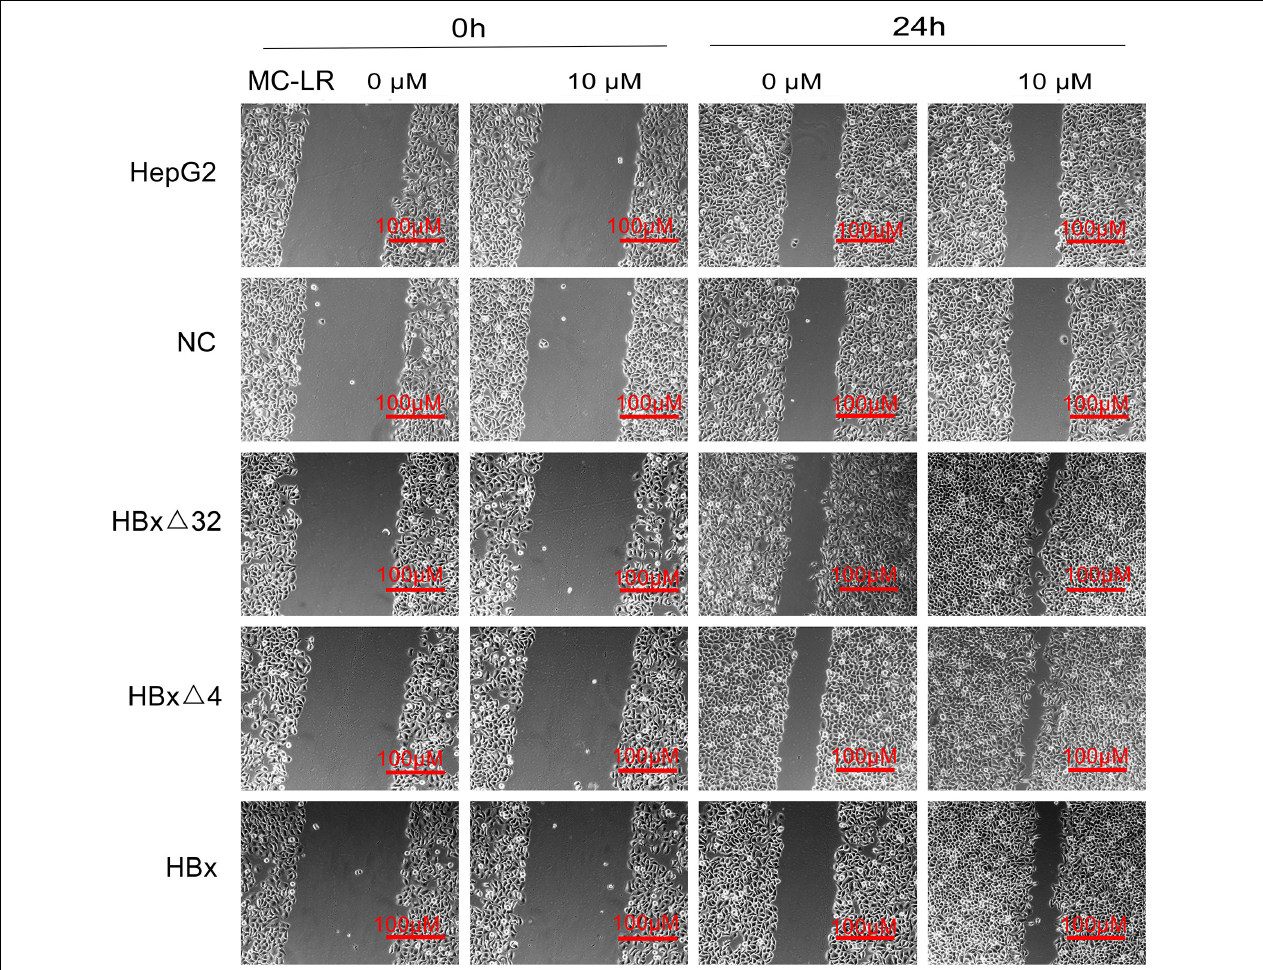
FIGURE 3 | Effect of MC-LR and ctHBx on the motility ability of HepG2 cells. Scratch wound analysis of cells at 0 and 24 h after treating with 10 µ M MC-LR. The fold changes in the scratch of the HBx (cid:49) 32, HBx (cid:49) 4, and HBx groups exposed to MC-LR (10 µ M) were significantly higher than those of the NC and HepG2 groups ( F = 28.351, P = 0.001), the motility ability of HBx (cid:49) 32 and HBx (cid:49) 4 groups were stronger than HBx group (HBx (cid:49) 32 vs. HBx P = 0.001; HBx (cid:49) 4 vs. HBx P =